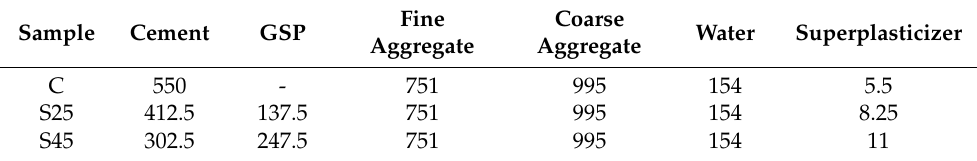
Table 2. Mix proportions of high-strength concrete/kg · m − 3